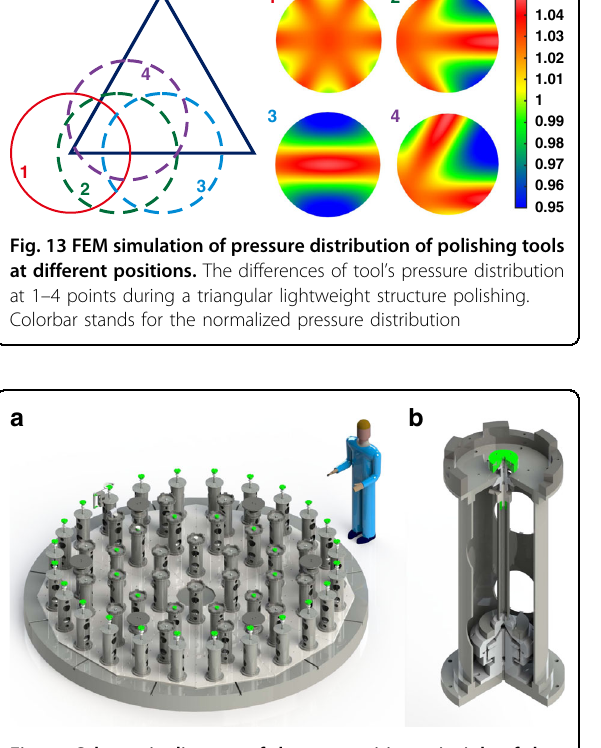
Fig. 14 Schematic diagram of the composition principle of the hydrostatic support system and structural design of the hydrostatic unit. a Map of Gravity unloading system distribution 40 .